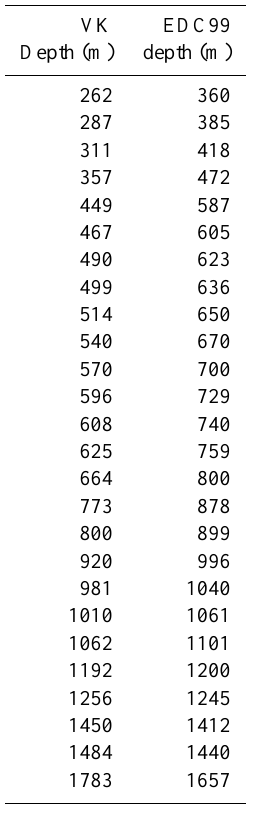
Table 5. Isotopic synchronization between VK and EDC99. VK depth is a combination of different logging depths (as defined